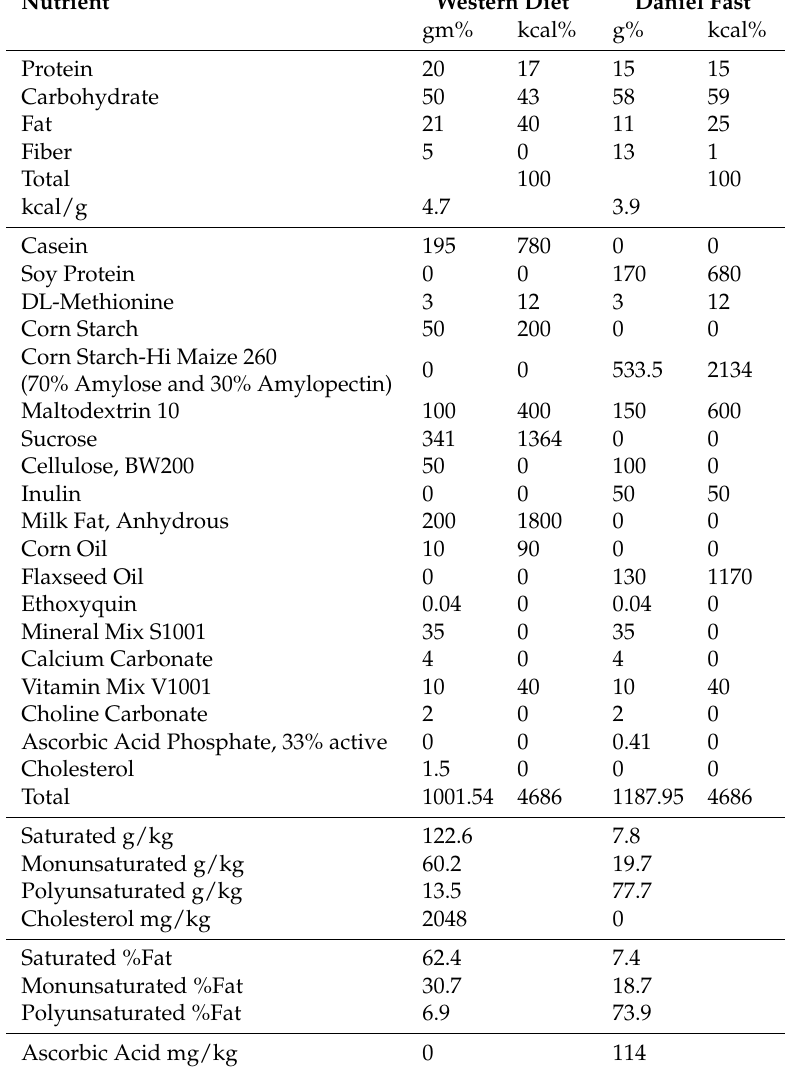
Table 1. Dietary composition of the Western Diet and Daniel